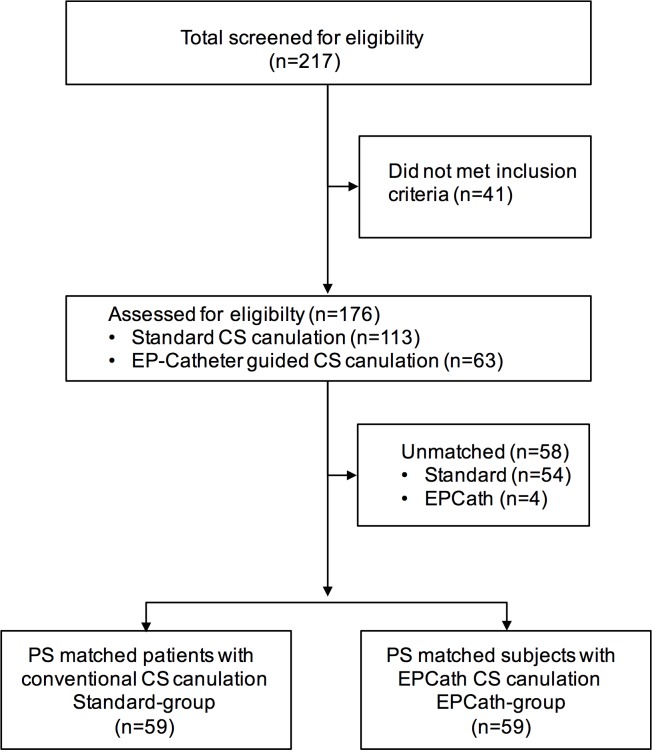
Study flow chart.